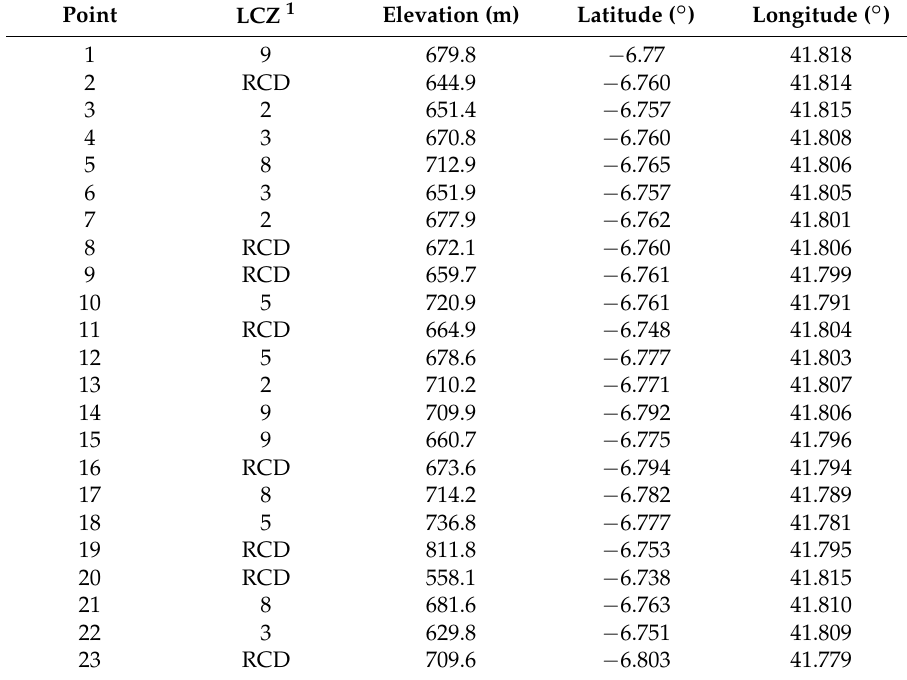
Table 1. Measuring points location.